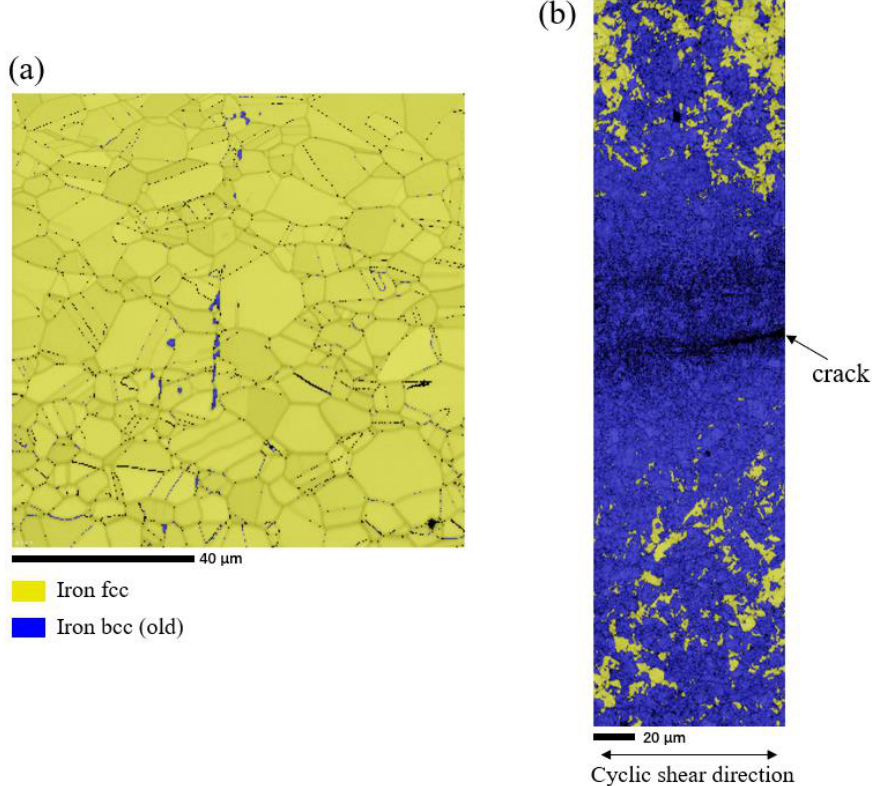
Figure 10. EBSD phase image of specimen fatigued cycle. ( a ) Phase image of the original specimen, ( b ) phase image of the specimen after experiment.